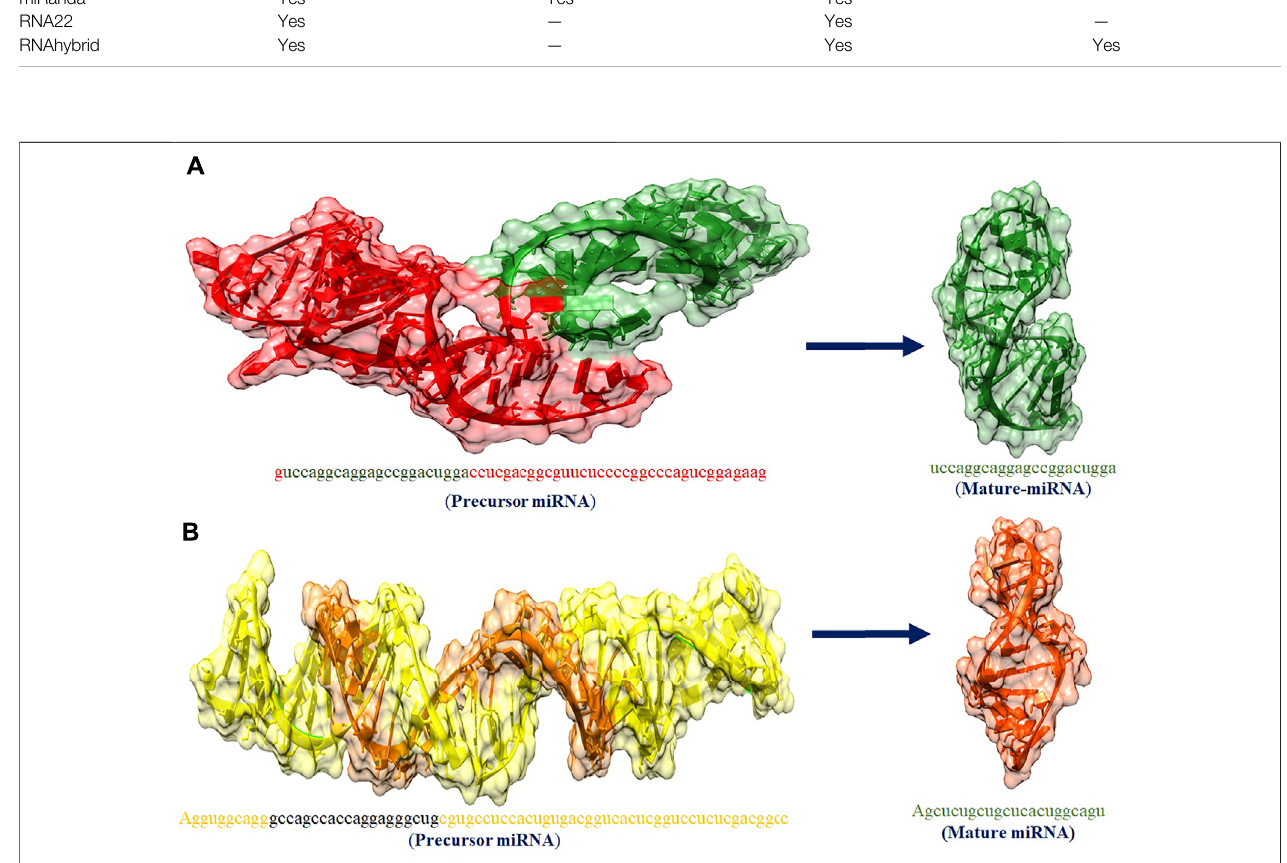
FIGURE 7 | (A , B) The predicted 3D structures of premature and mature has_mir_4673 and has_mir_3194_3p miRNAs,